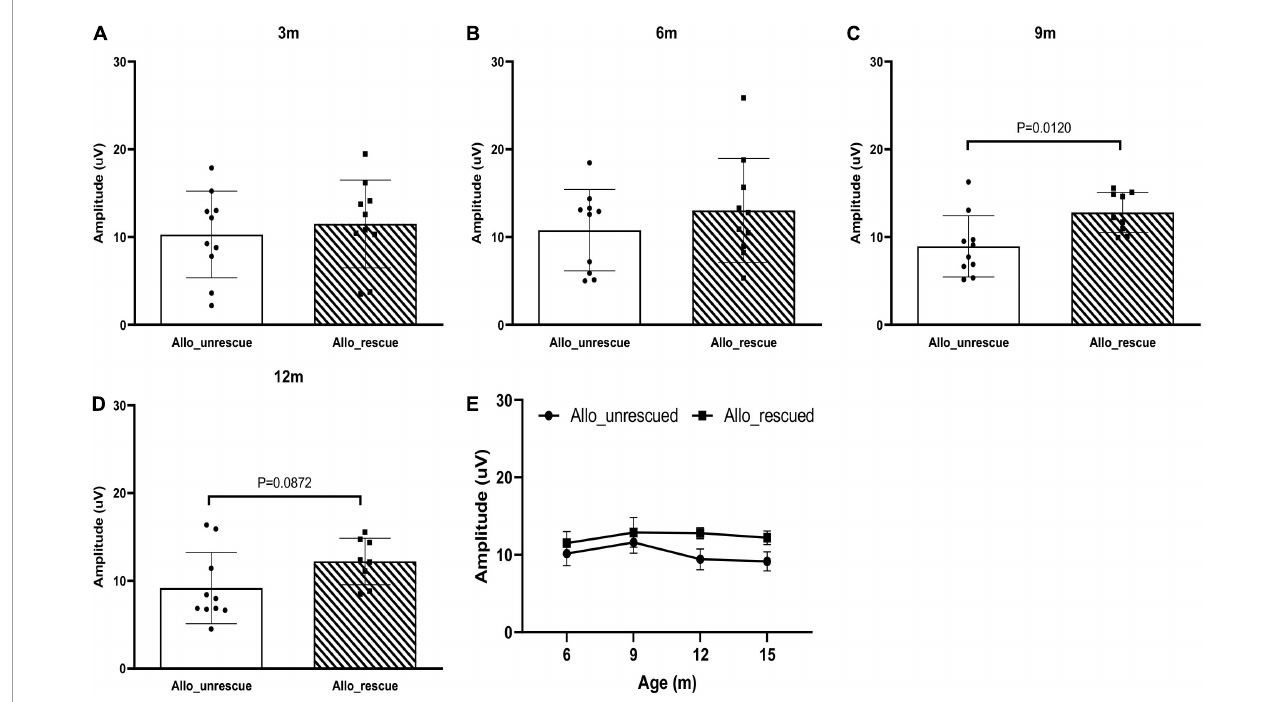
FIGURE3 Allotopic expressed wtND4 rescue mutND4-induced RGC dysfunction. Scatterplots of PERG amplitudes (average of both eyes) of all mice tested in each group showed PERG amplitude of unrescued (Allo–unrescue) and rescued (Allo_rescue) mice at 3 months (A) , 6 months (B) , 9 months (C) , and 12 months (D) post-injection. (E) A line graph shows the mean PERG amplitude for un-rescued mice significantly decreased with age relative to rescued mice from 9 to 15 months after